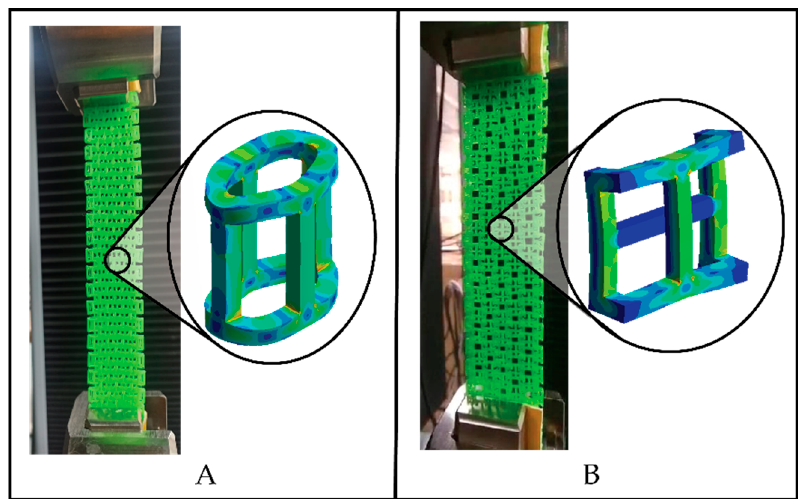
Figure 9. Analysis by CAE modeling of the stresses in the different elements that constituted the 3D printed textile structures. ( A ) cylindrical elements; and ( B ) prismatic elements.